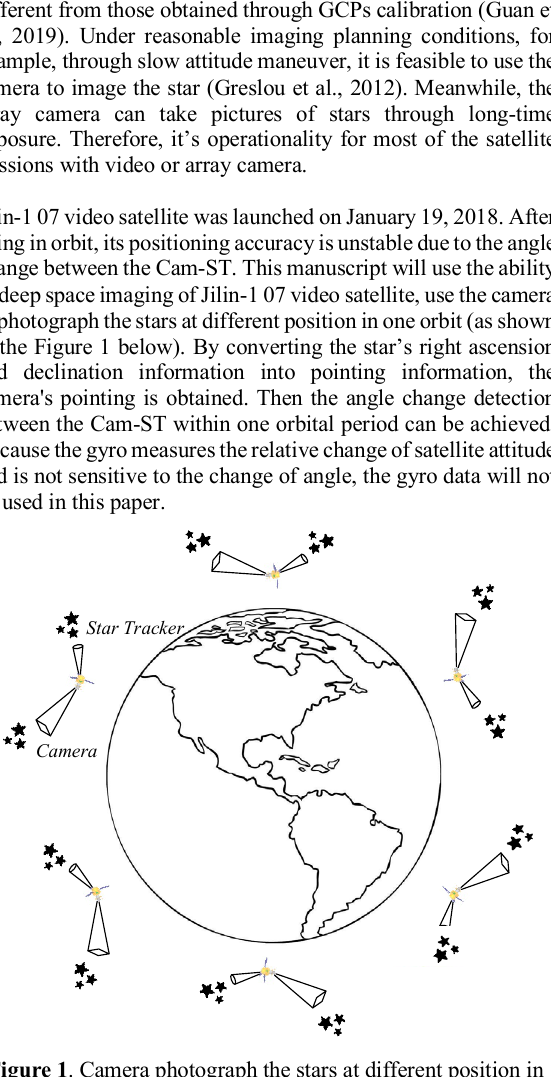
Figure 1 . Camera photograph the stars at different position in one orbit.